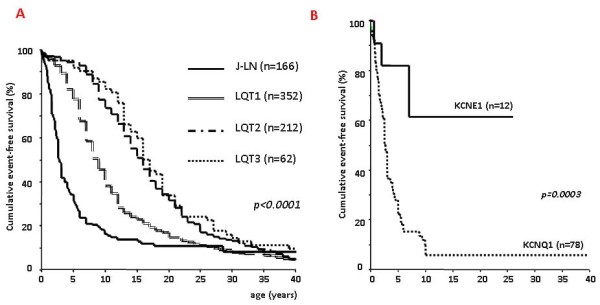
(A) Kaplan-Meier curves of event-free survival comparing JLN patients vs LQT1, LQT2 and LQT3 symptomatic patients.(Modified from ref. [3] with permission from Lippincott Williams and Wilkins). (B) Kaplan-Meier curve of event-free survival in JLN patients with mutations in KCNQ1 or KCNE1 genes. (Reprinted from ref. [3] with permission from Lippincott Williams and Wilkins).